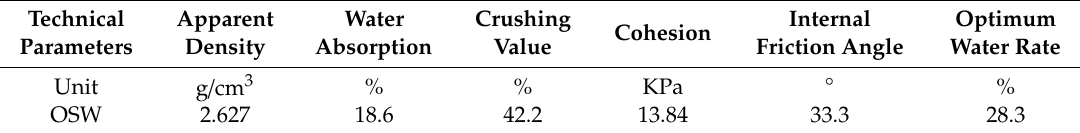
Table 2. Technical parameters of oil shale waste (OSW).